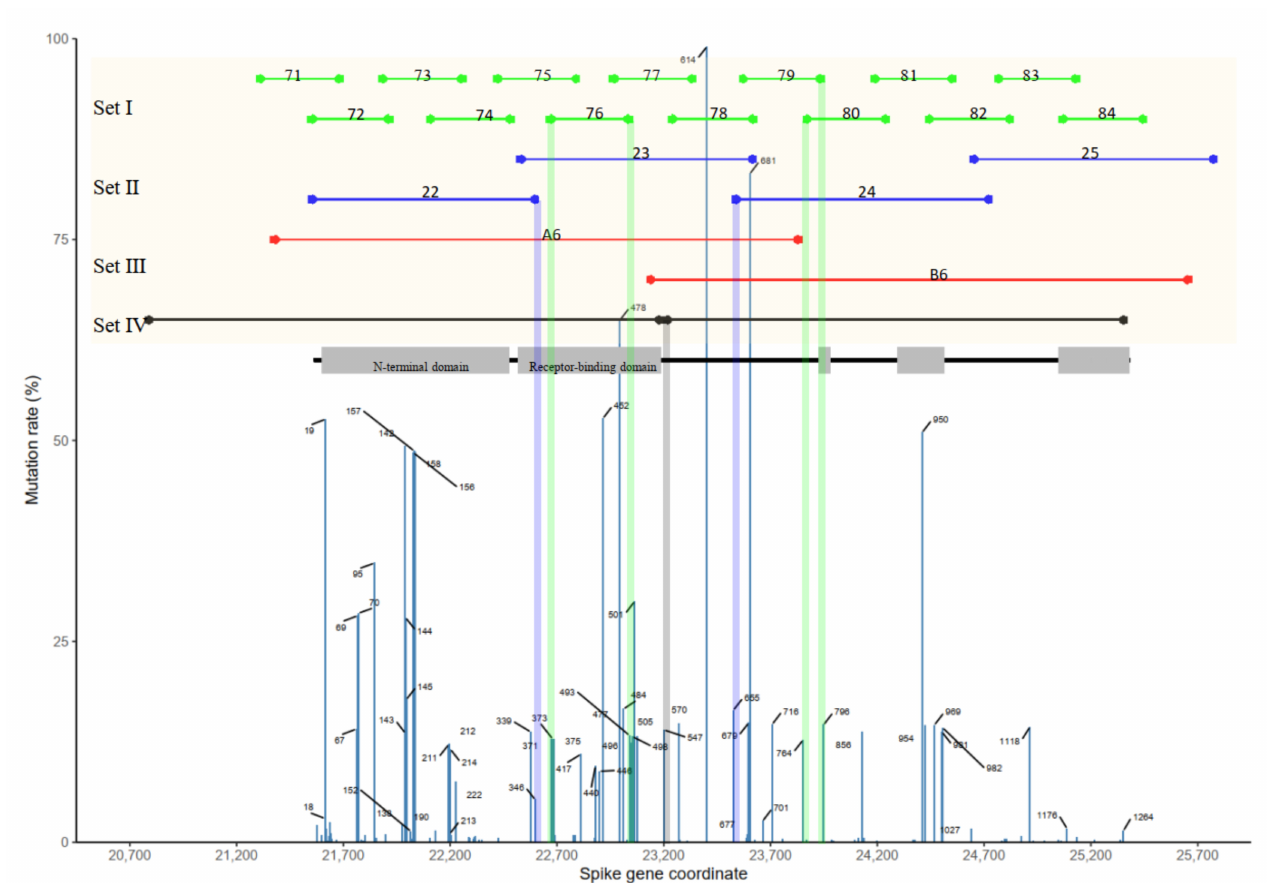
Figure 2. Coordinates of primer sets and the mutation rate of spike protein based on the hCov19 Mu- tation Dashboard on 12 February 2022. Green, blue, red, and black horizontal lines represent primer set I, set II, set III, and our primer set (set IV) covering the spike gene of SARS-CoV-2,